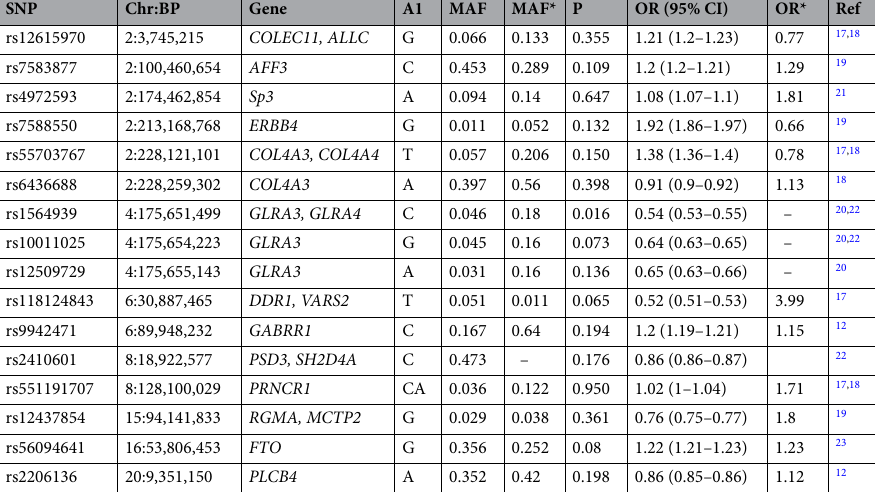
Table 5. Association of previous loci reported with DKD and kidney function in diabetic patients in the UAE cohort. A1: effective allele; BP: base pair, indicating chromosomal location; Chr: chromosome; CI: confidence intervals; MAF: minor allele frequency of the UAE cohort; MAF*: minor alleles frequency according to the reference study; OR: odds ratio; OR*: odds ratio according to the reference study; Ref: